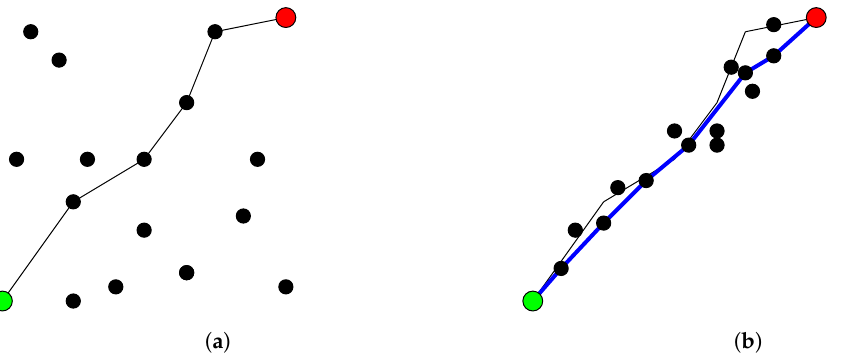
Figure 9. Sampling: The first path ( left ) is computed by the FMT algorithm from a sampling on the whole space. The second path ( right in blue) is computed from a sampling around the first approximate path (start point in green and end point in red). ( a ) First sampling; ( b ) second sampling.